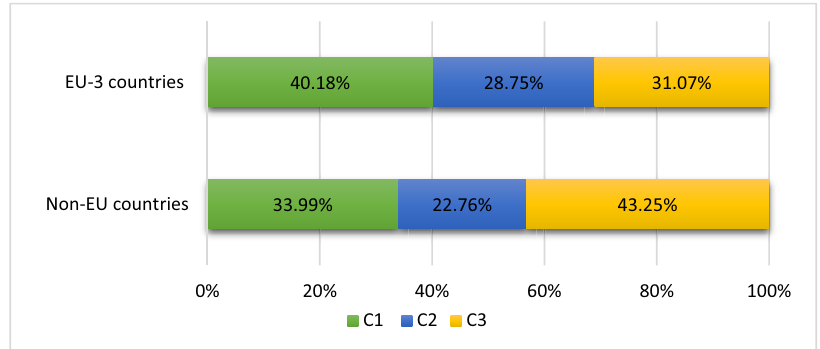
Figure 1: Respondents ’ distribution by clusters and EU Membership. Source: Calculated by the authors based on OECD primary data ( 2019 ) .